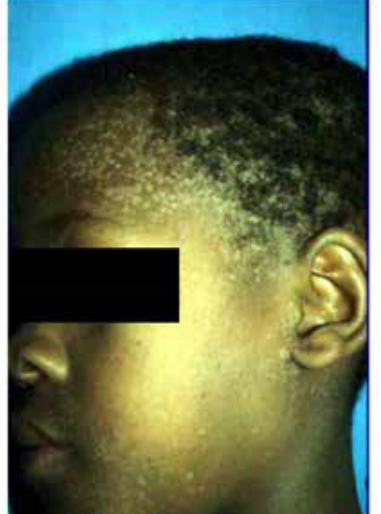
Figure 4. Extensive verruca plana